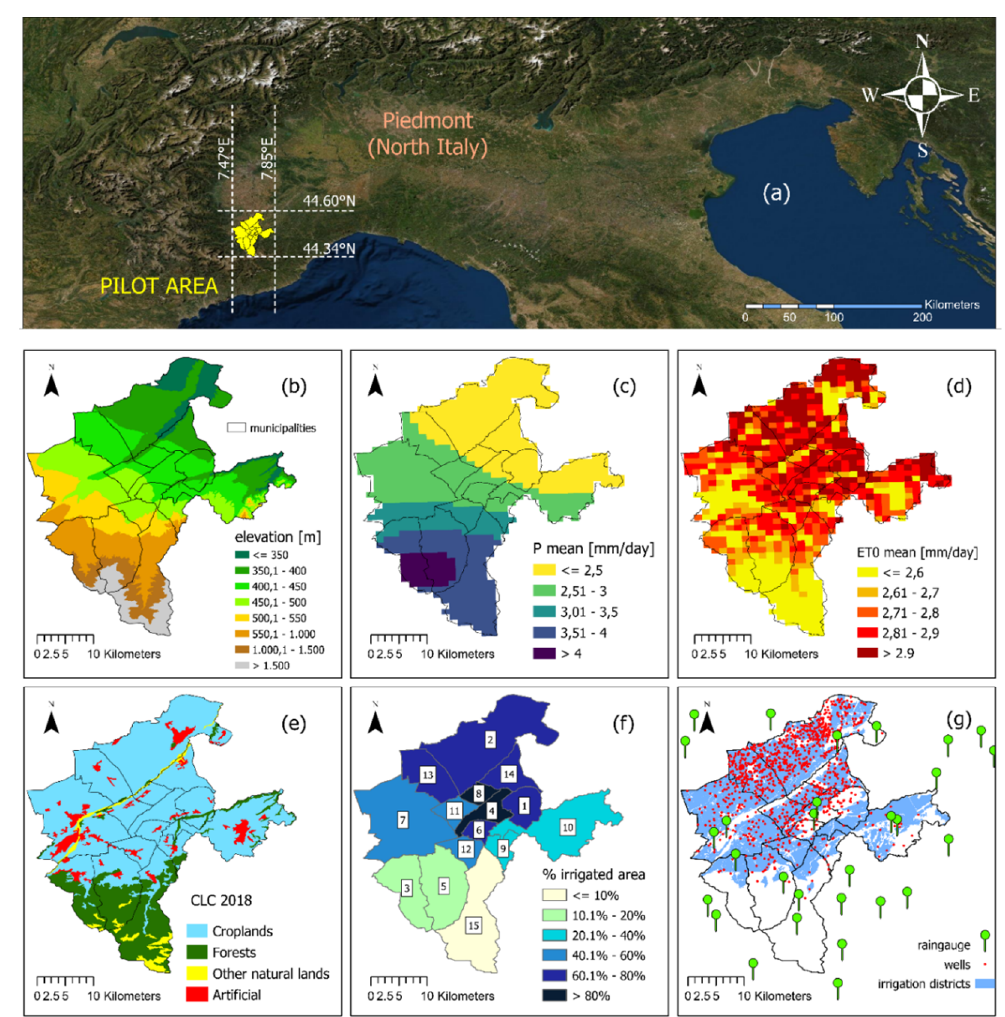
Figure 1. Characterization of the pilot area: location, elevation above mean sea level, climate, croplands, irrigation districts. ( a ) Location and limits of the pilot area (7.47°E to 7.85°E, 44.34°N to 44.6°N): 15 municipalities in the province of Cuneo (North – West Italy). ( b ) Spatial elevation above the sea level [m], 10 m × 10 m resolution. ( c ) Mean daily precipitation [mm/day] from April to October (average 1970–2019). ( d ) Mean daily reference evapotranspiration [mm/day] from April to October (average 1970–2019). ( e ) Land classification of the pilot area, according to the Corine Land Cover (2018) information. ( f ) Fractions of irrigated croplands [%] with respect to the overall municipal areas: Rocca de’ Baldi (1), Fossano (2), Boves (3), Morozzo (4), Peveragno (5), Margarita (6), Cuneo (7), Montanera (8), Pianfei (9), Mondovì (10), Castelletto Stura (11), Beinette (12), Centallo (13), Sant’Albano Stura (14), Chiusa di Pesio (15). ( g ) Irrigation districts and infrastructures, including rain